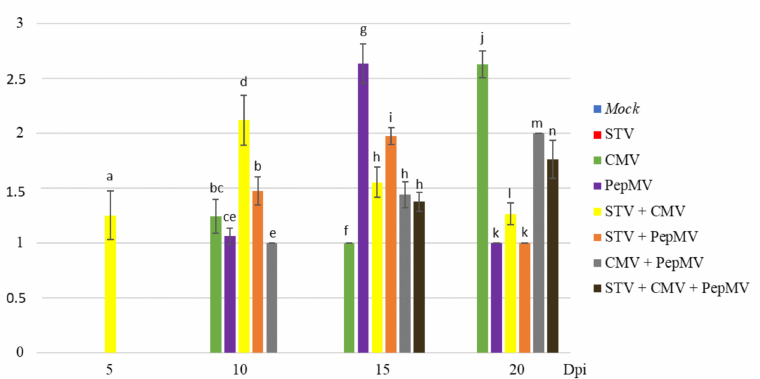
Figure 2. Graphic representation (mean values) of leaf symptoms severity (ordinate axis) of tomato plants infected with STV, PepMV, and CMV in single and mixed infections at 5, 10, 15, and 20 dpi (abscise axis). Leaf symptoms intensity was scored from 0 to 3, where 0 corresponds to symp- tomless, and 1, 2, and 3 to mild, moderate, and severe symptoms, respectively. Bars and let- ters up to the columns correspond to standard errors (from 0 to 0.23) and different plant groups ( p -value ≤ 0.05),